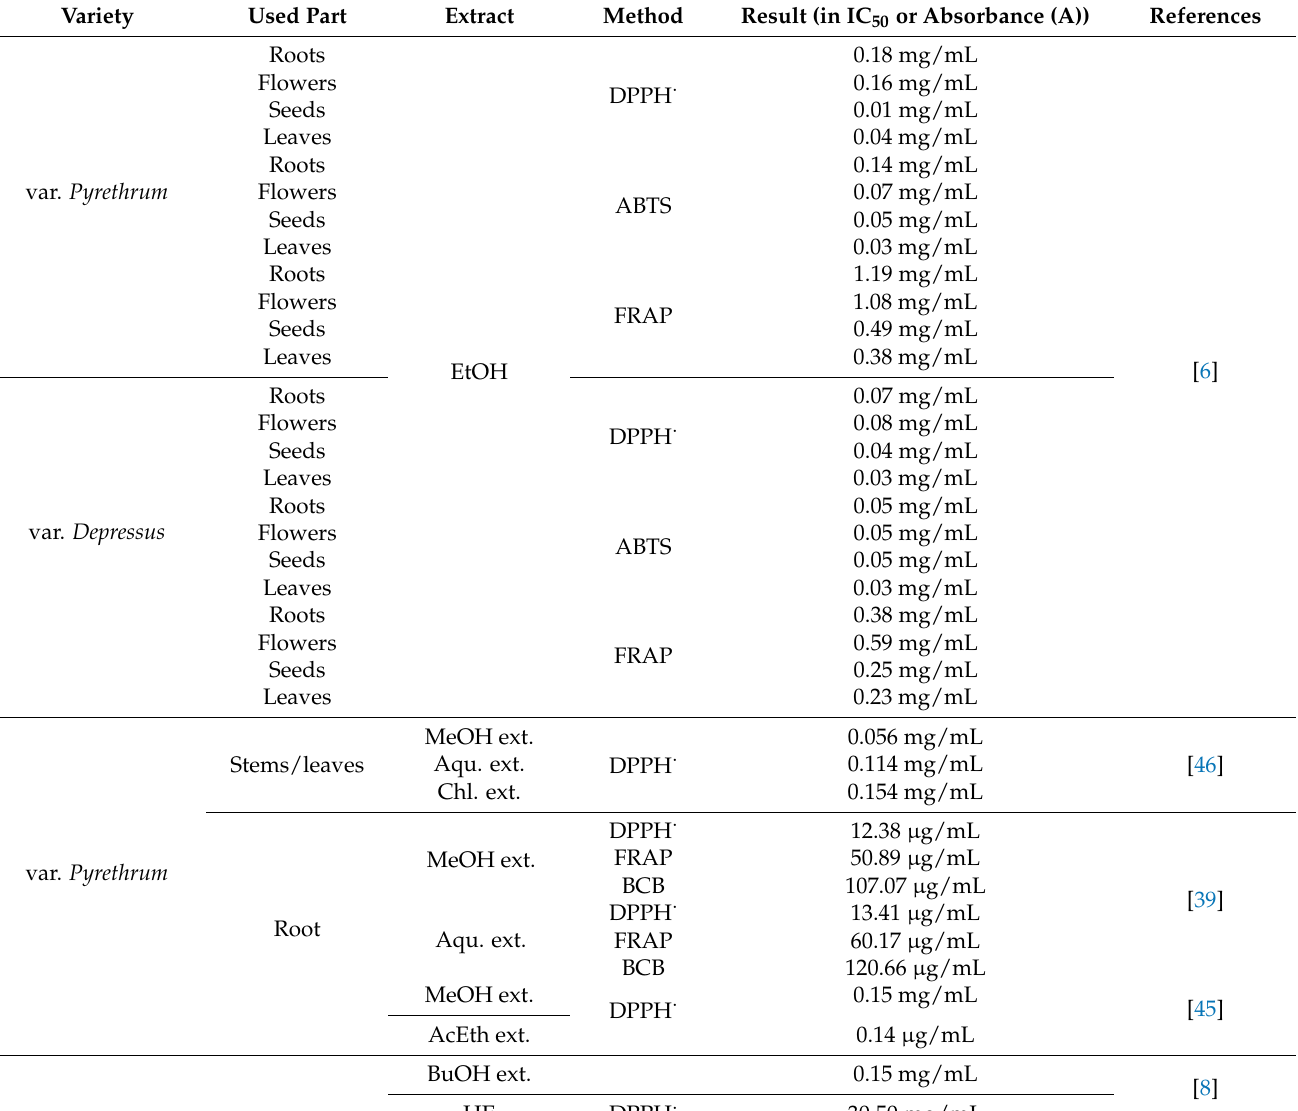
Table 2. Antioxidant activity of A. pyrethrum (var. pyrethrum (L.) and var. depressus (Ball)